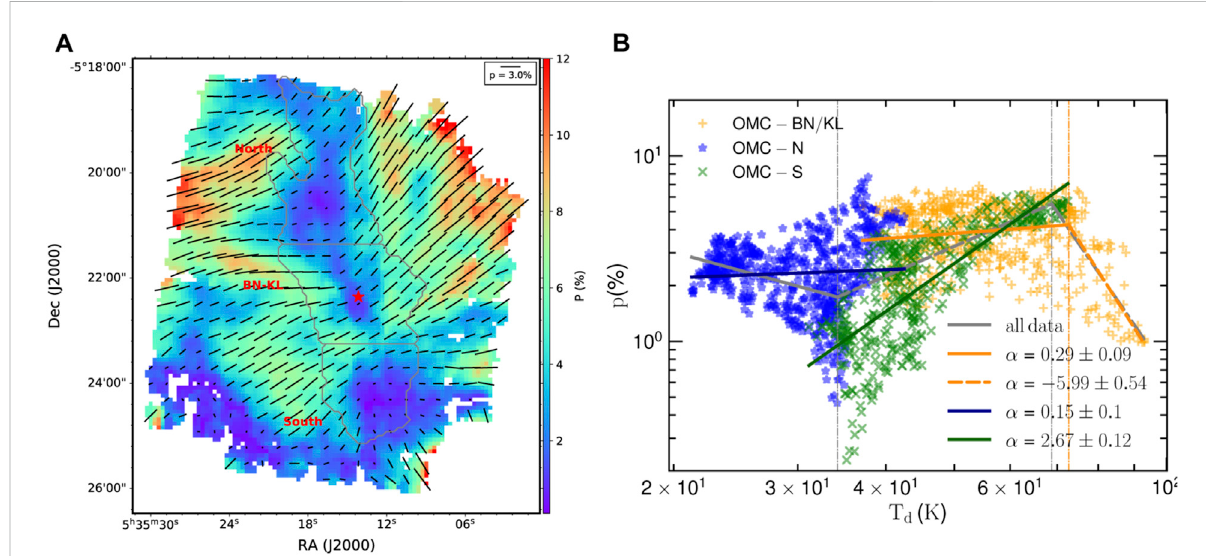
FIGURE 12 (A) SOFIA/HAWC + observations of OMC-1 at 214 μ m. The background color is polarization degree. The black vectors illustrate the B- fi eld morphologyinferredfromthermaldustpolarization(Ngocetal.inpreparation).Threesub-regions,namely,BN-KL,north,andsouthareselectedfor further analysis. (B) The relation of polarization degree at 214 μ m to dust temperature at three sub-regions in OMC-1 (Ngoc et al. in preparation). In OMC-N and OMC-S, p is seen to monotonically increases with T d . The increment in the fi rst sub-region is faster than the latter one. It differs from OMC-BN/KL, for which p slightly increases before deeply decreasing to higher T d